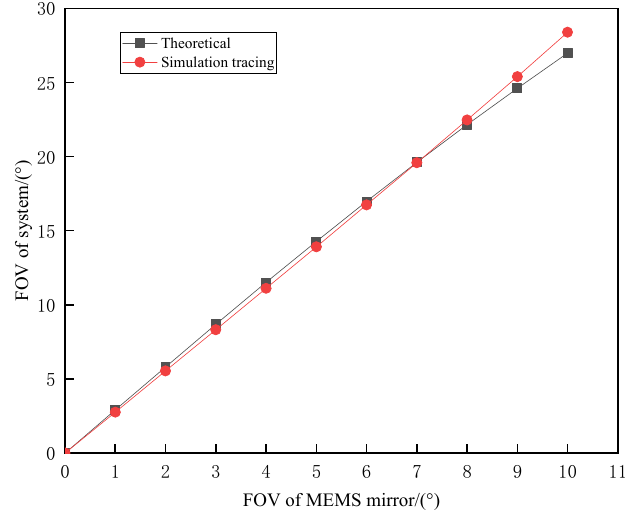
Figure 11. Comparison of the FOV between theoretical calculation and simulation.